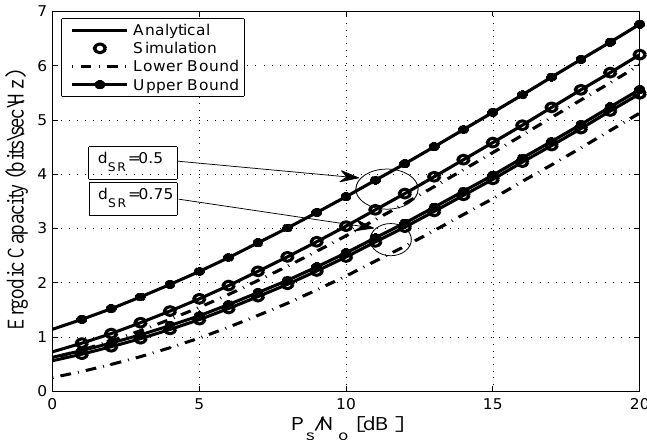
Figure 3. Ergodic capacity vs. P S / N o for different values of d SR and d RD for γ ID = γ RR = 5 dB, m ij = 2, and η = 3.18.